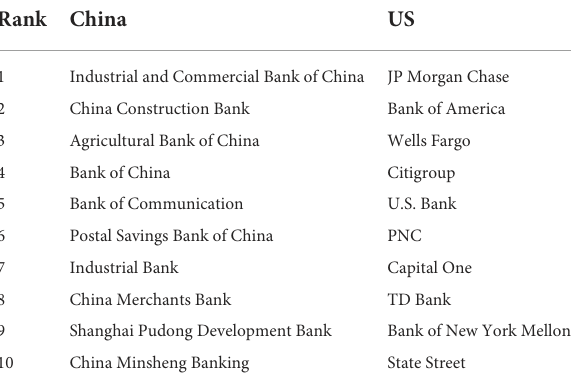
TABLE 1 Top 10 commercial banks in China and the United